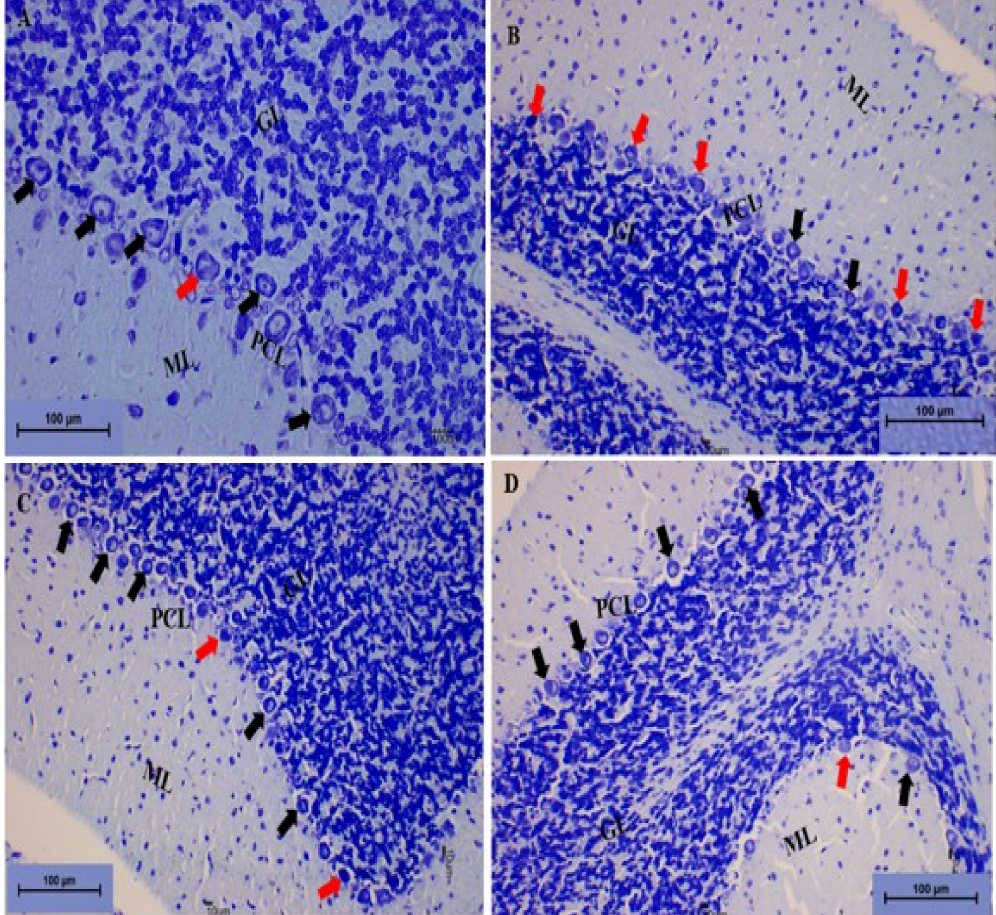
Figure 16. Photomicrograph sections of the cerebellums from the di ff erent rat groups. ( A ) Control group showing the white matter (W) and the three layers of the cerebellar cortex: The molecular layer (ML), the granular layer (GL), and the Purkinje cell layer (PCL) with the Purkinje cells (black arrow) showing prominent nuclei. ( B ) RC showing the Purkinje cells having deeply stained cytoplasm with distorted shapes (red arrow) and the molecular layer showing scattered glial cells (ML). ( C ) Cur100 and ( D ) Cur200 showing the restoration of the molecular layer (ML) and granular layer (GL); the Purkinje cell layer (PCL) appears to be arranged in a linear pattern with the Purkinje cells (black arrow) having prominent nuclei and a regular shape. Toluidine blue, 200 × , scale bar = 100 µ